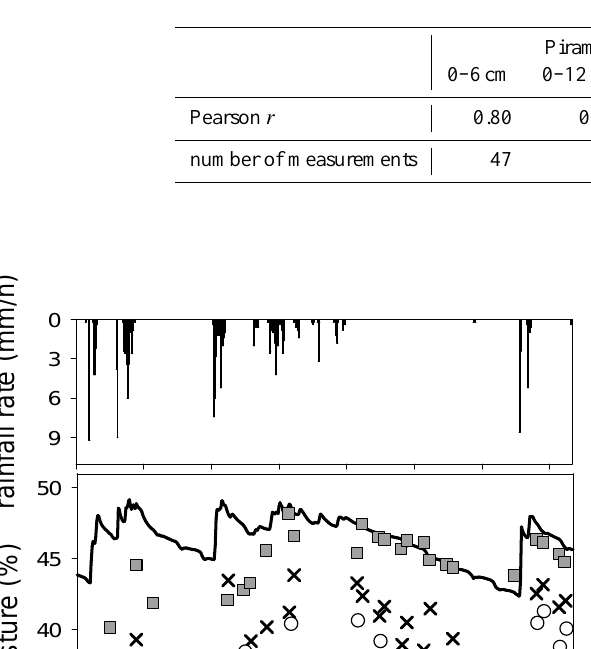
Table 1. Pearson correlation coefficients for the relation between the average of the four soil moisture measurements at 0–30cm and the hillslope-averaged soil moisture at three depths at Piramide and Emme for 2005 and 2006 study periods.